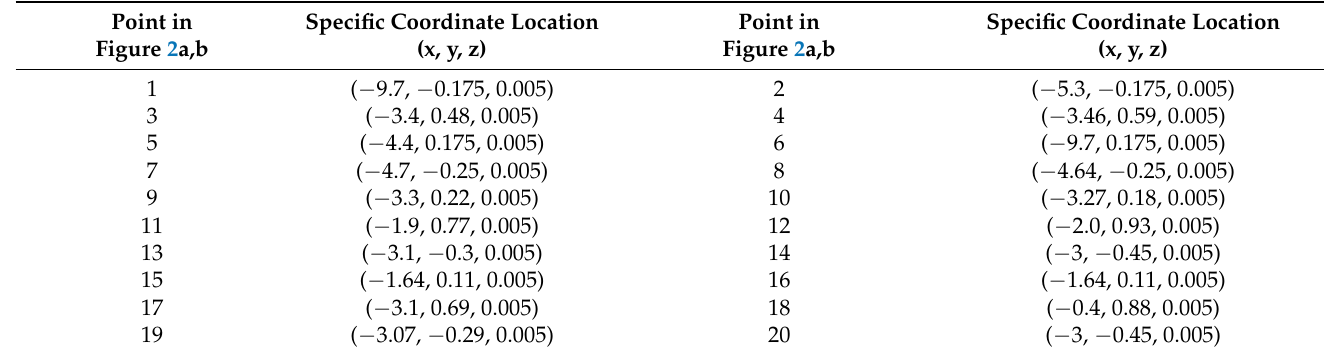
Table 2. The specific coordinate location of each point in Figure 2a,b on the surface of the model in (x, y, z) form (unit: mm).